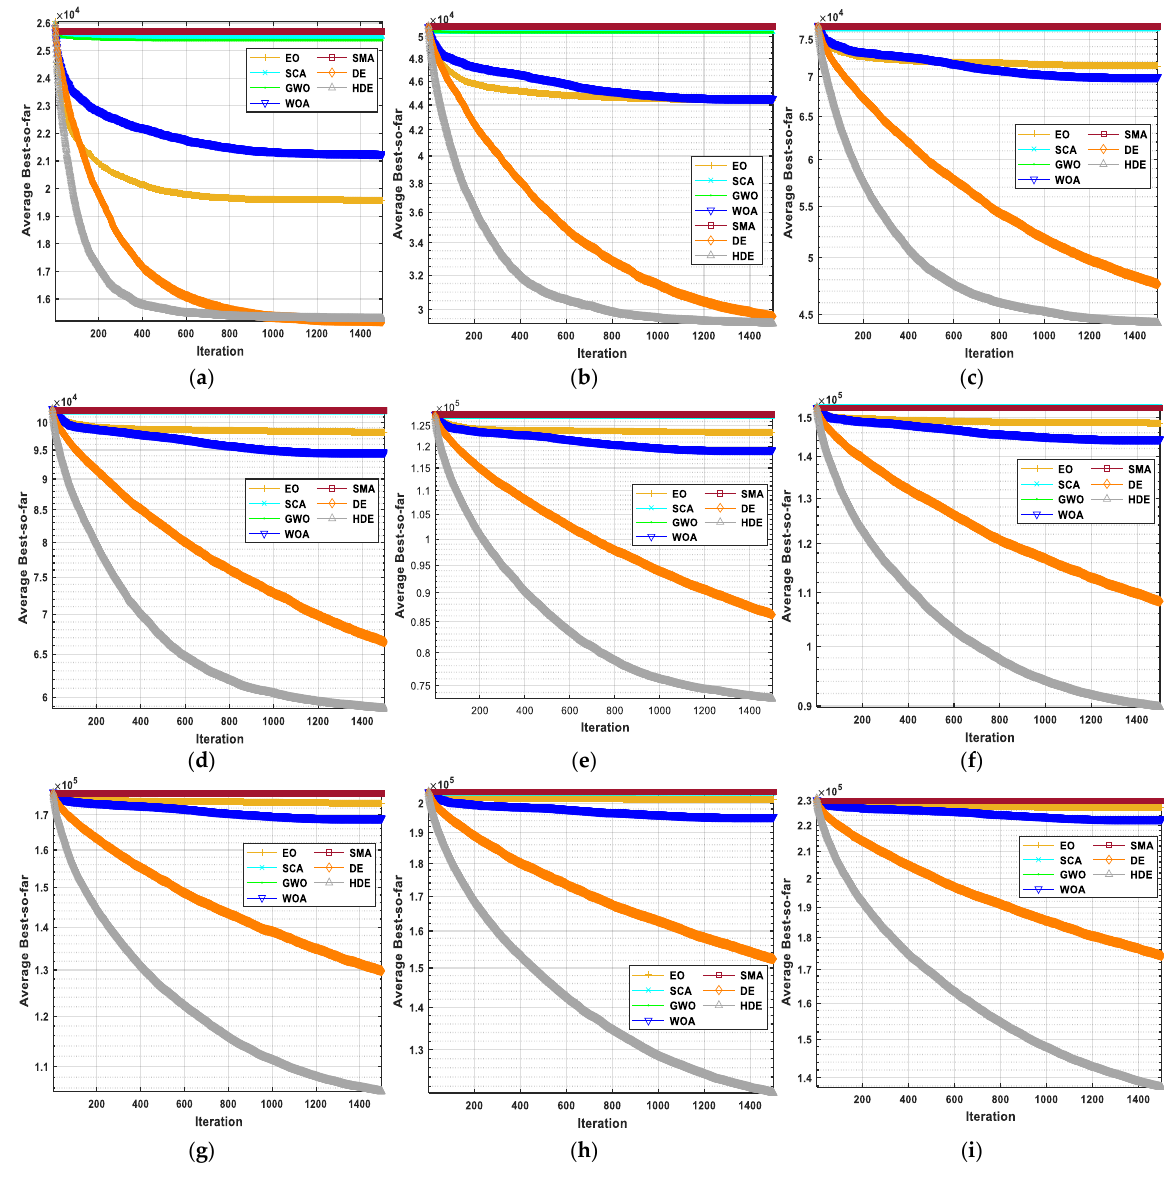
Figure 11. Comparison of algorithms in terms of convergence speed: ( a ) Comparison for the task size of 100; ( b ) Comparison for the task size of 200; ( c ) Comparison for the task size of 300; ( d ) Comparison for the task size of 400; ( e ) Comparison for the task size of 500; ( f ) Comparison for the task size of 600; ( g ) Comparison for the task size of 700; ( h ) Comparison for the task size of 800; ( i ) Comparison for the task size of 900.